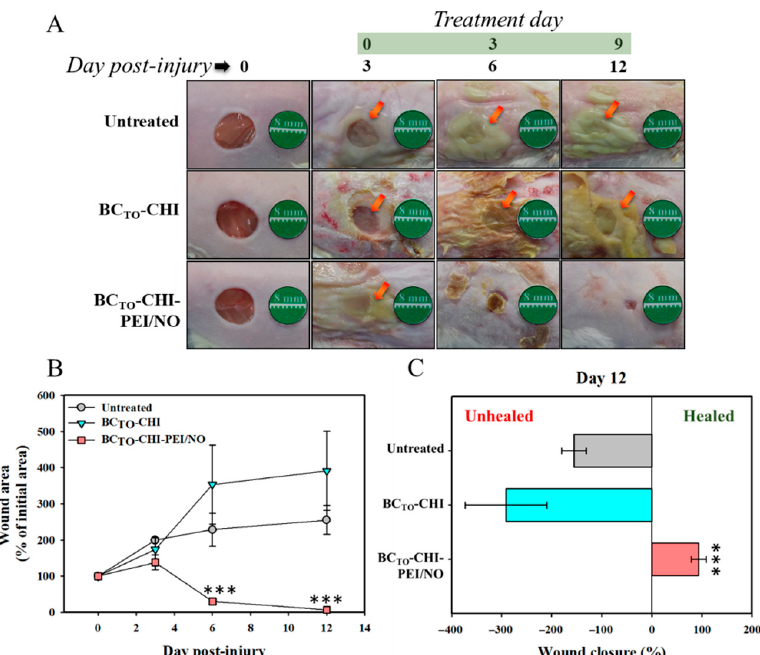
Figure 7. Wound healing assay in mice. ( A ) Representative photographs of polymicrobial-infected wounds of ICR mice treated with or without BC TO -CHI and BC TO -CHI-PEI/NO hydrogels. The orange arrows indicate polymicrobial infection ( B ) Wound area reduction percentage of mice skin lesions in comparison to the initial 8mm wound. Values are the mean ± standard deviation, n = 10 wounds, and “***” indicates p < 0.001 compared to the untreated group. ( C ). Wound closure percentage of mice skin lesions at final day in comparison to the initial 8mm wound.